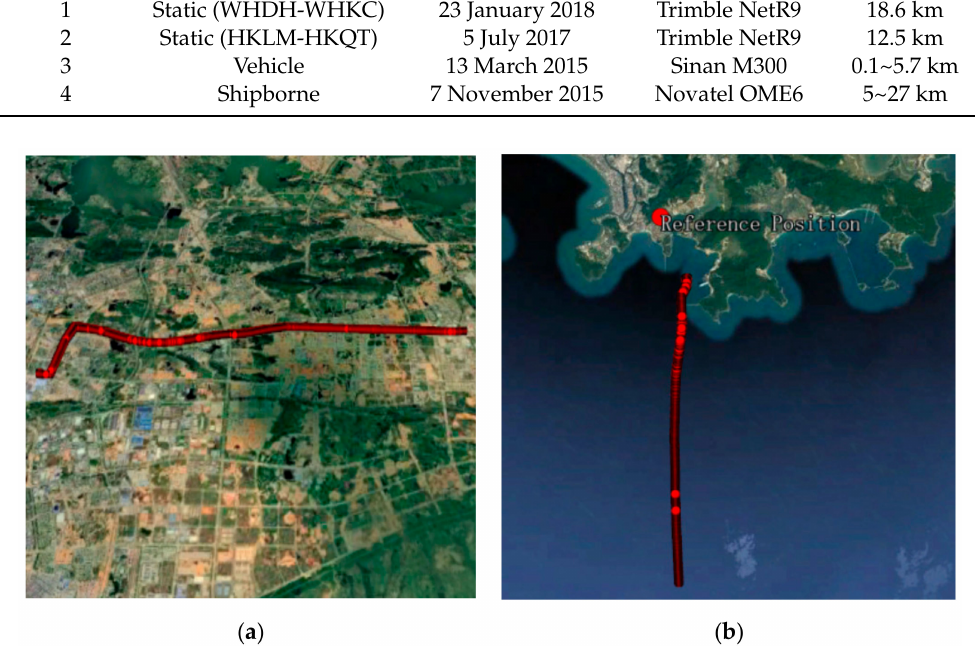
Figure 6. Dynamic trajectory of Dataset3 ( a ) and Dataset4 ( b